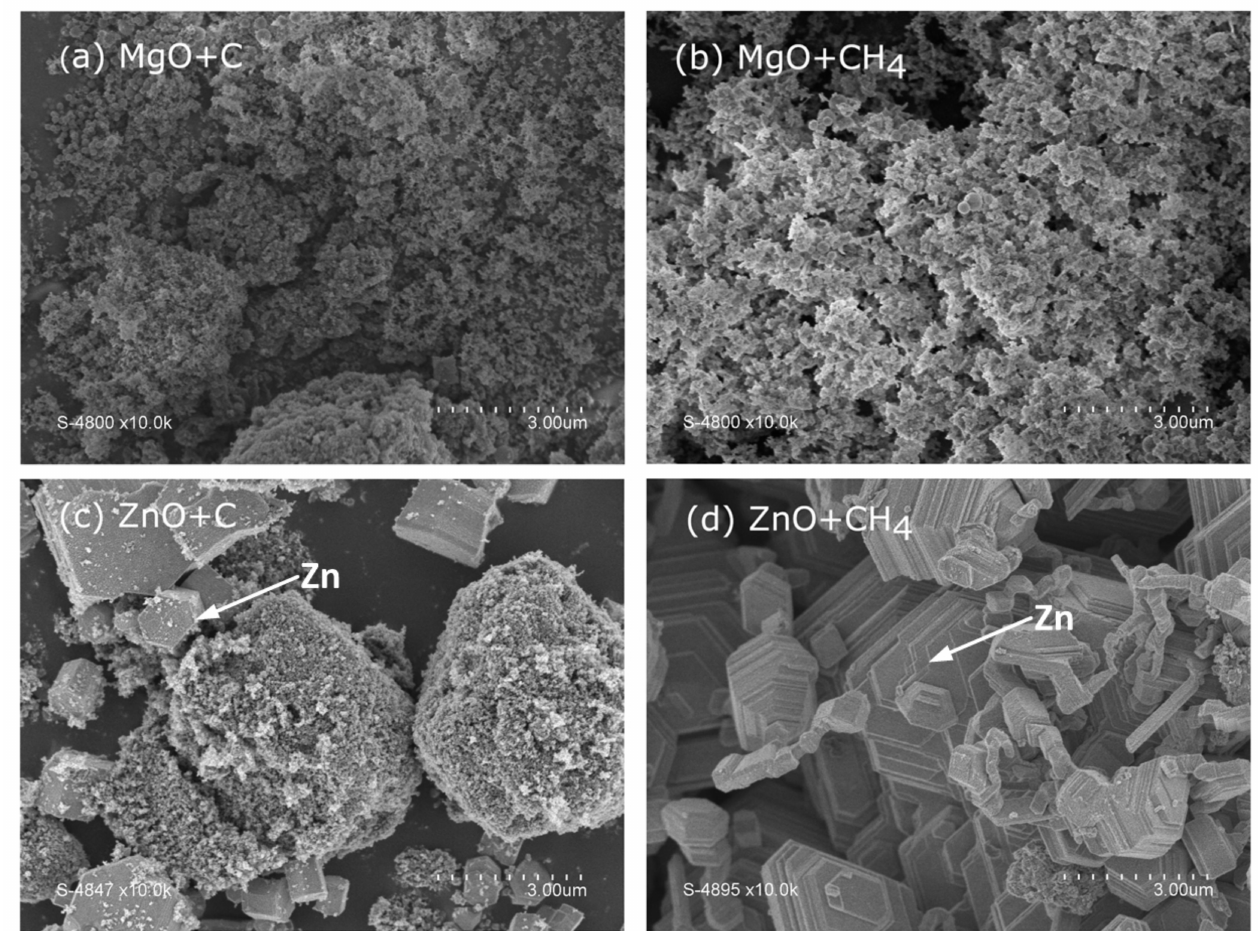
Figure 11. FESEM micrographs of solid products collected in the filter (zone B): ( a ) the CTR of MgO, ( b ) the MTR of MgO, ( c ) the CTR of ZnO, and ( d ) the MTR of